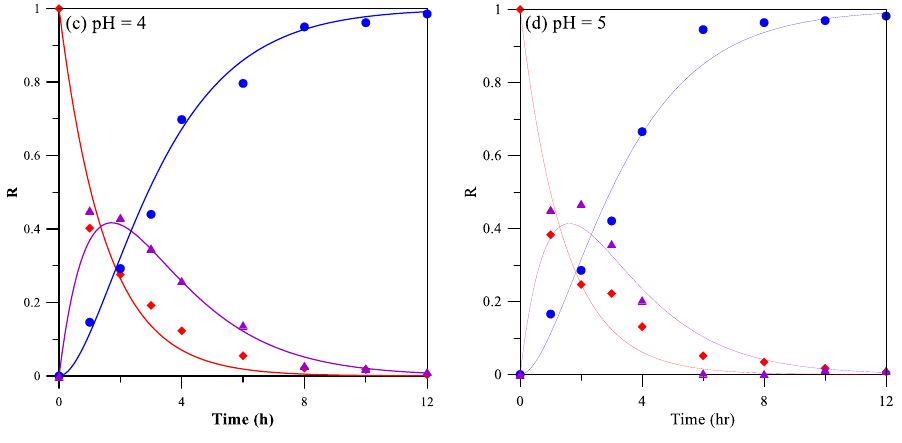
Figure 6. The variations of Cr(VI) concentrations with respect to time. R f ( ♦ ), R m ( ▲ ), and R s ( ● ). Feeding phase: [Cr(VI)] = 53 mg/L; stripping phase: NaOH solution at pH 12; stirring rate: 450 rpm.